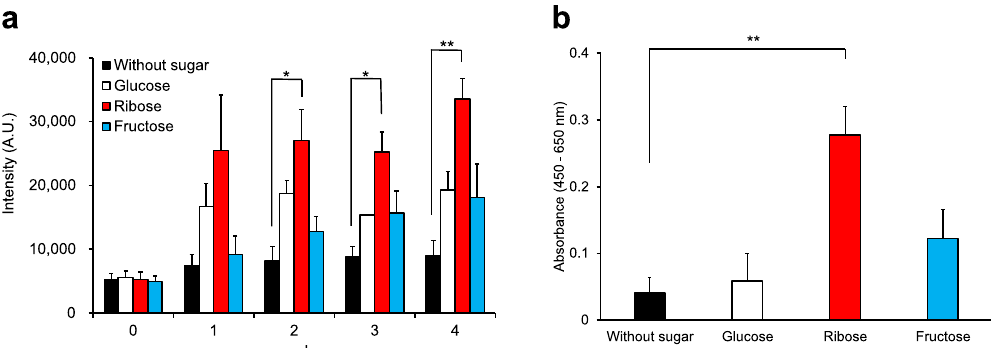
Fig. 2 Blue fl uorescence and AGEs of worms ’ extracted proteins after in vitro glycation. a Auto fl uorescence (ex 340/em 430) from worm proteins (wild-type N2) after incubation with sugars for four weeks in vitro. Two-factor factorial ANOVA was applied with Scheffe ’ s F test. b AGE levels on the fourth week were also measured by ELISA with anti-CML antibody and expressed as the absorbance. Data are shown as mean ± SE. Single-factor ANOVA was applied with Dunnett ’ s test; * and ** indicate statistically signi fi cant differences at p values < 0.05 and < 0.01,